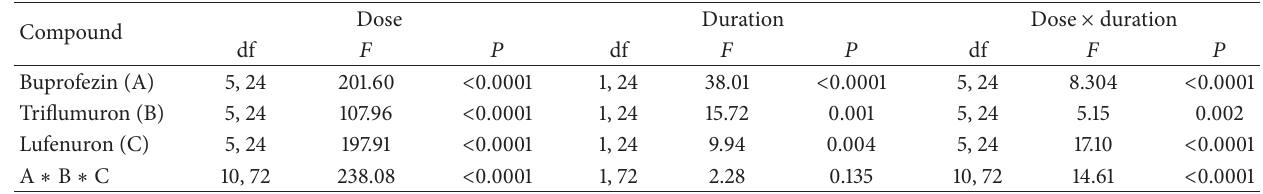
Table 6: ANOVA results on the glutathione S-transferase (GST) responses of mature earthworms ( A. caliginosa ) exposed to buprofezin, triflumuron, and lufenuron contaminated artificial